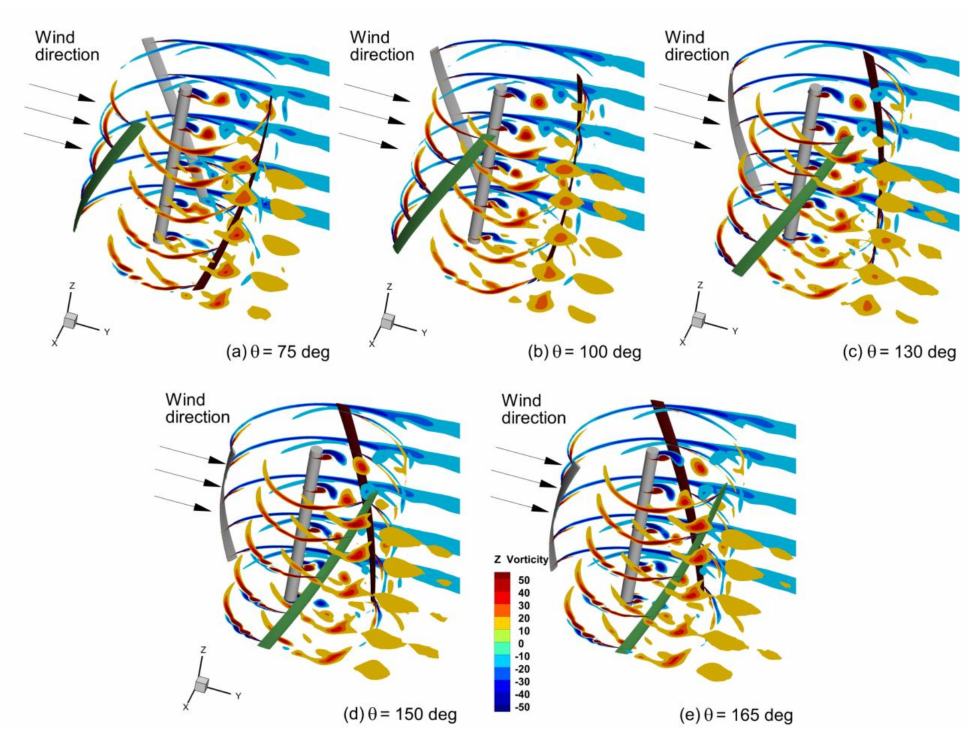
Figure 17. Z-vortex magnitude for 60 ◦ helical VAWT at z planes at heights of − 1.45 m, − 0.75 m, 0 m, 0.75 m, and 1.45 m at